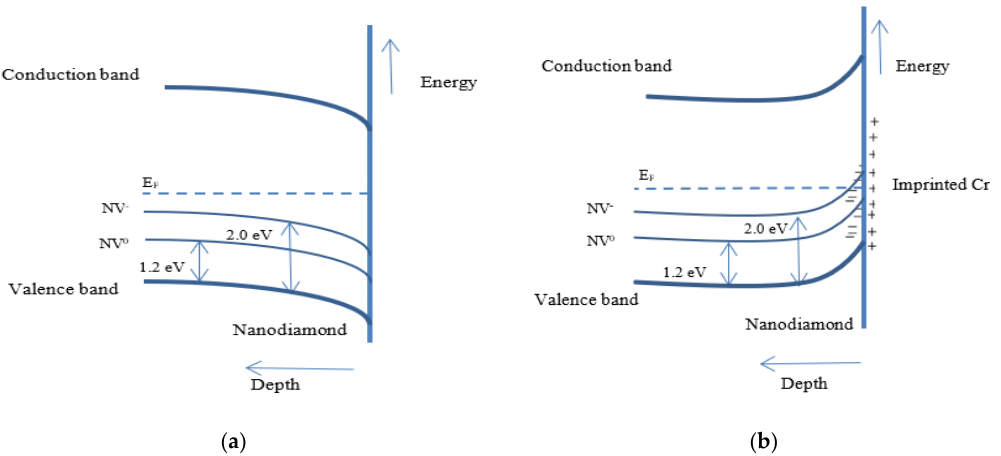
Figure 8. Nanodiamond band structure showing band bending near the surface ( a ) before creatinine addition with negative surface termination resulting in downward band bending and fully occupied nitrogen-vacancy centers and ( b ) after creatinine addition resulting in upward band bending and unoccupied NV − states near the nanodiamond surface.